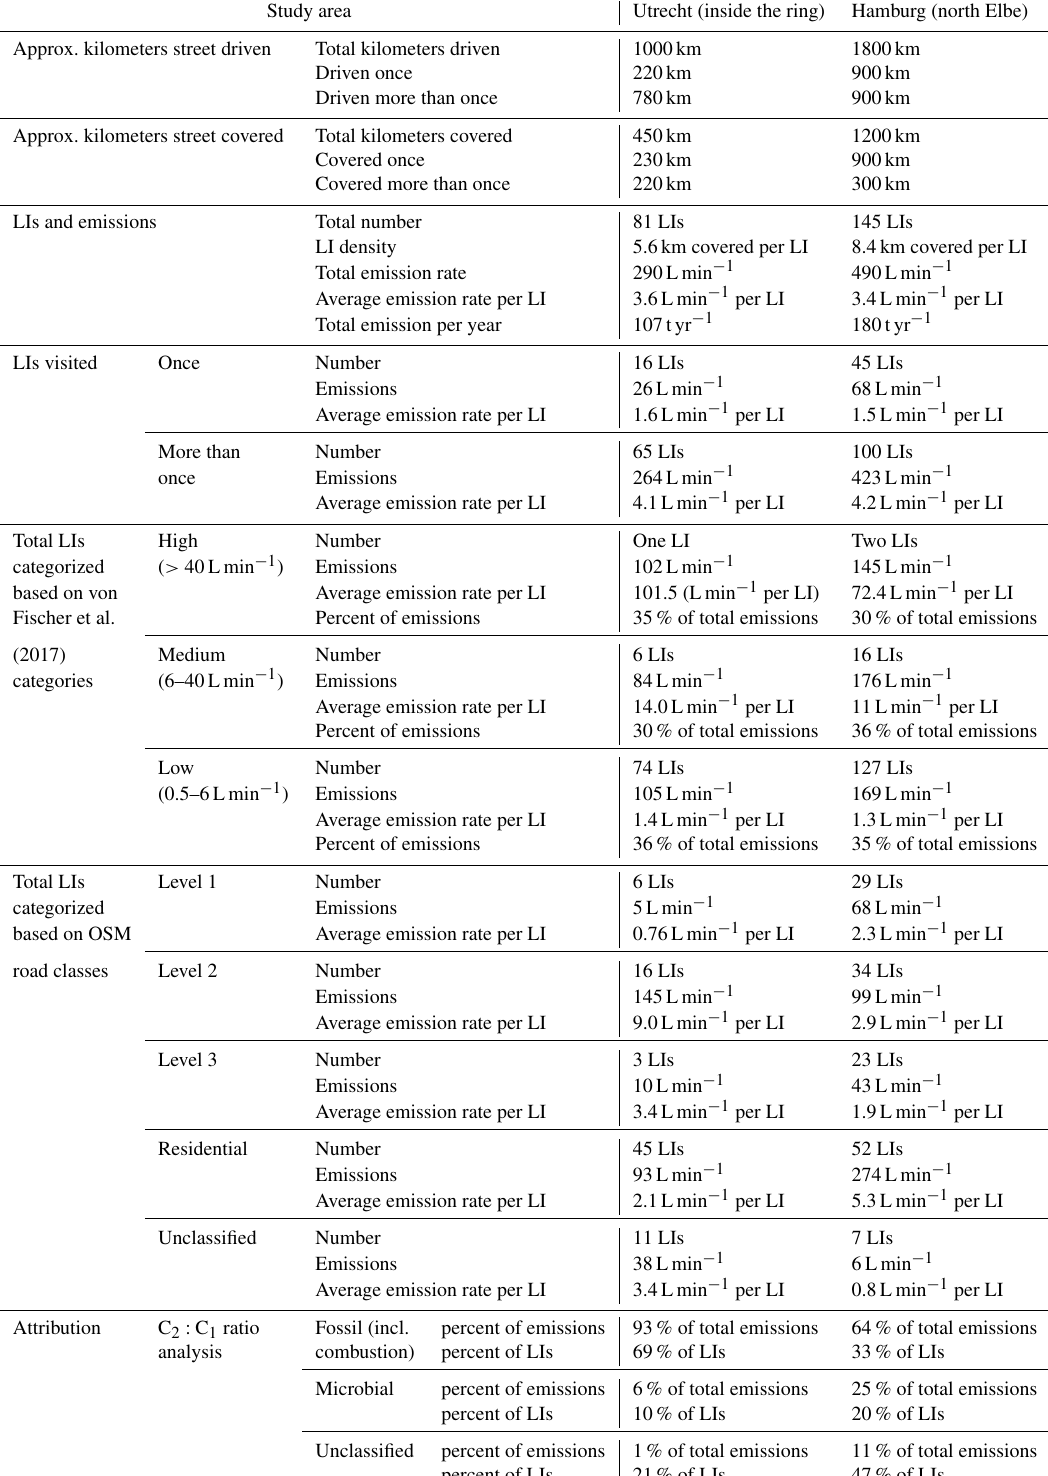
Table 2. Measurements and result summaries across the study area inside the ring in Utrecht and north Elbe in Hamburg. Study area Approx. kilometers street driven